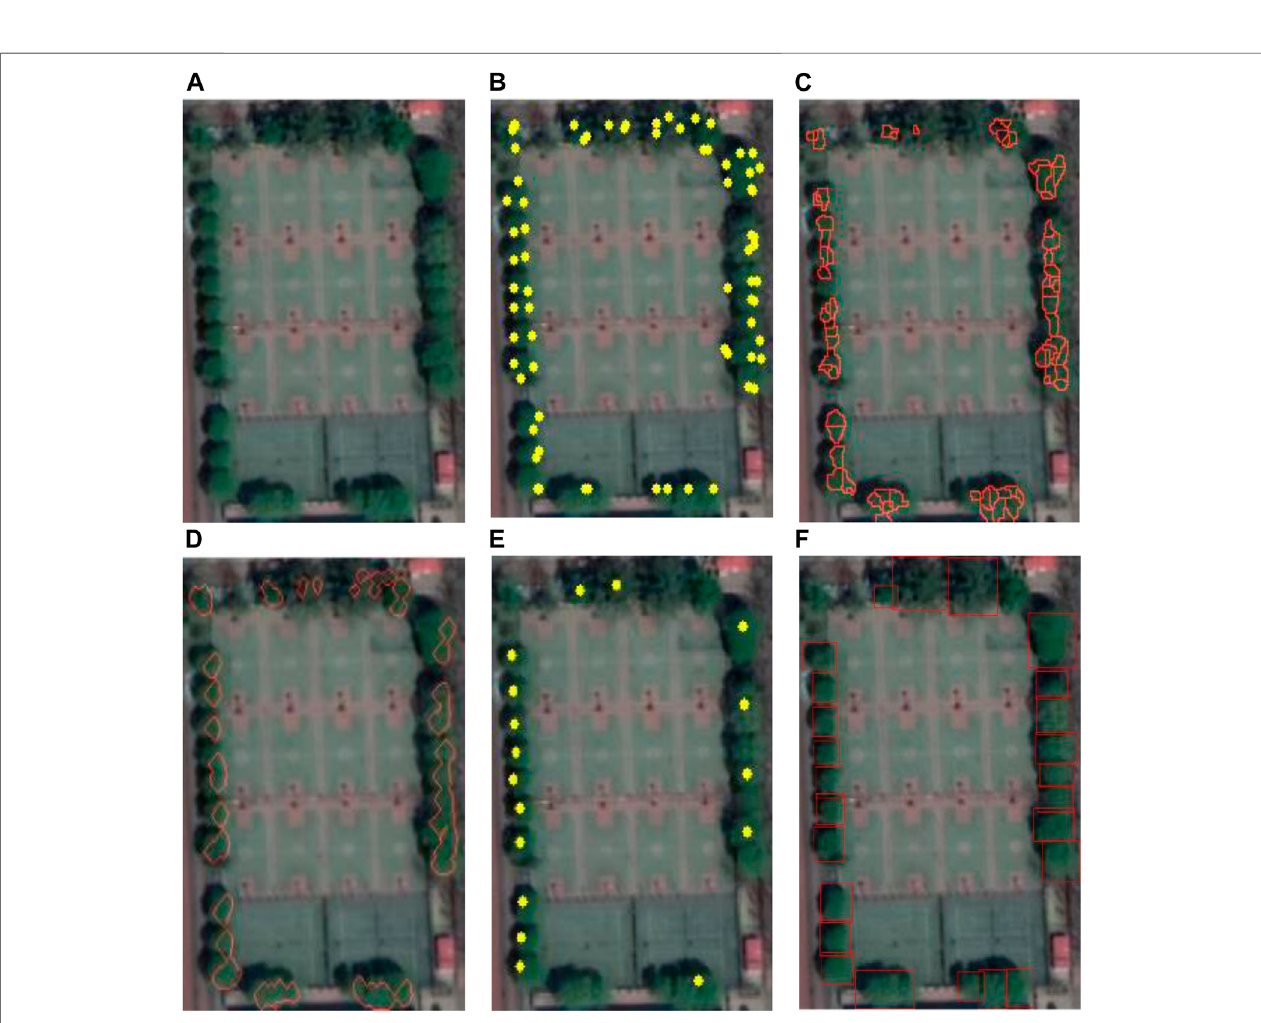
FIGURE 7 | Results of different methods in campus. (A) Original image. (B) Local max. (C) Watershed. (D) CV model. (E) Template matching. (F) SSD.